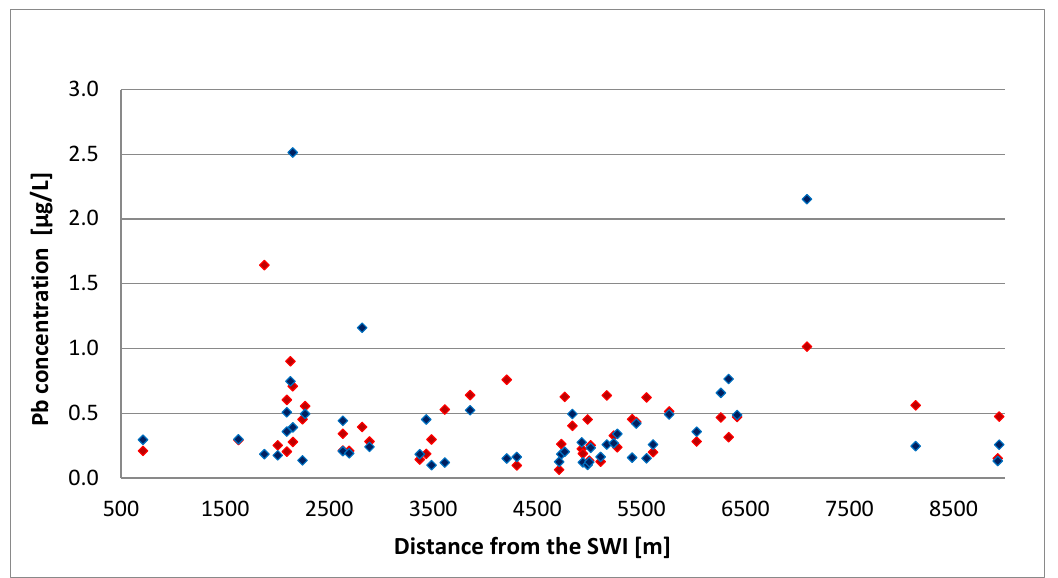
Figure 13. Ant and Flt concentrations in the most contaminated compartments in subject 1, E group.